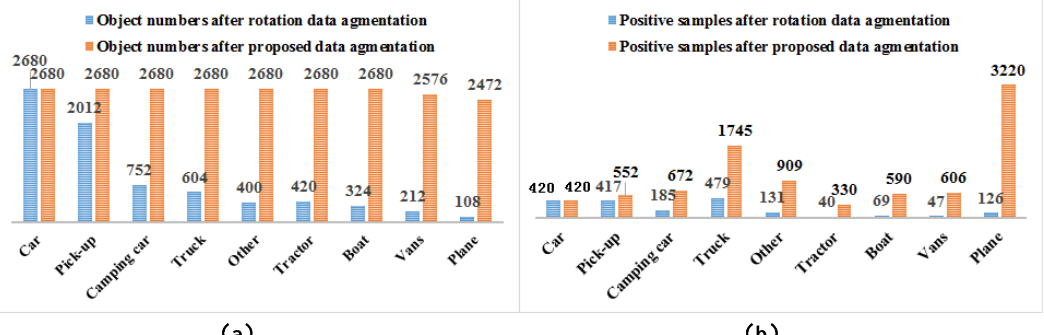
Figure 11. Comparison between rotation augmentation and proposed method of Group 2. ( a ) Object numbers ( b ) Positive samples (IOU > 0.7).